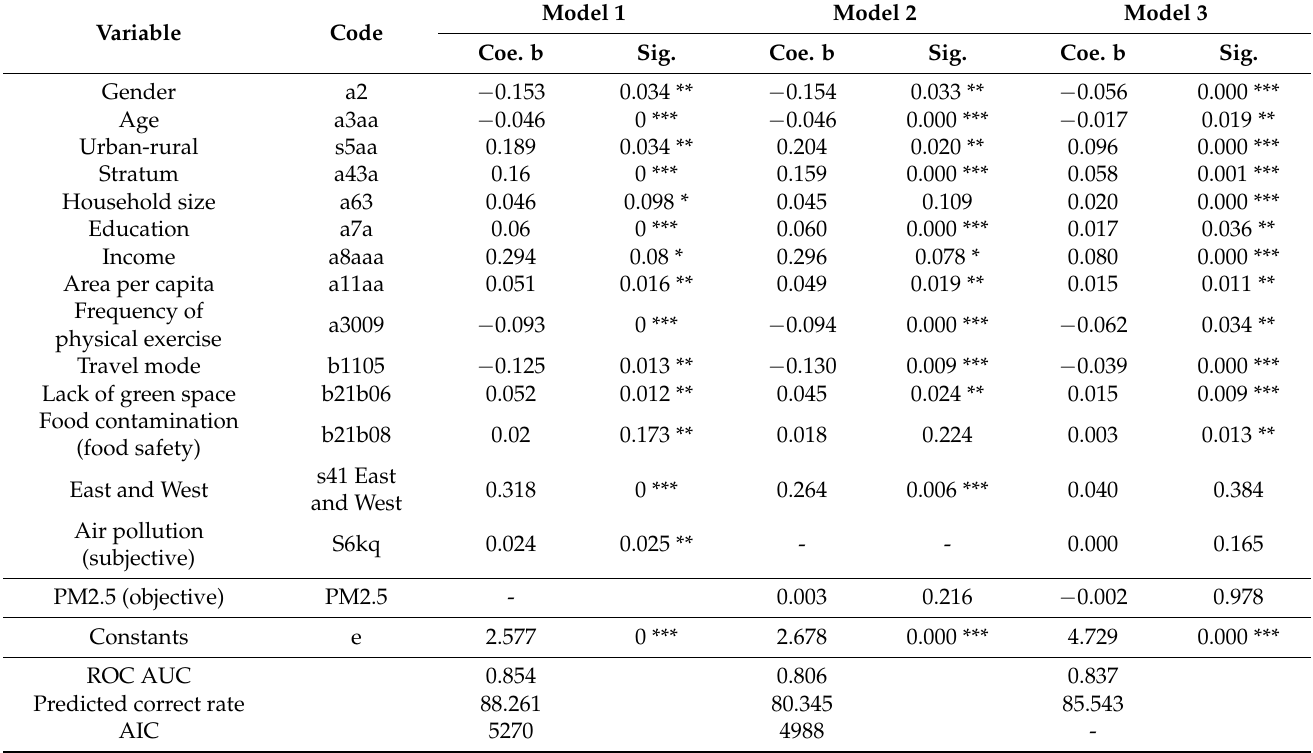
Table 3. Comparison of the full-sample multi-model regression